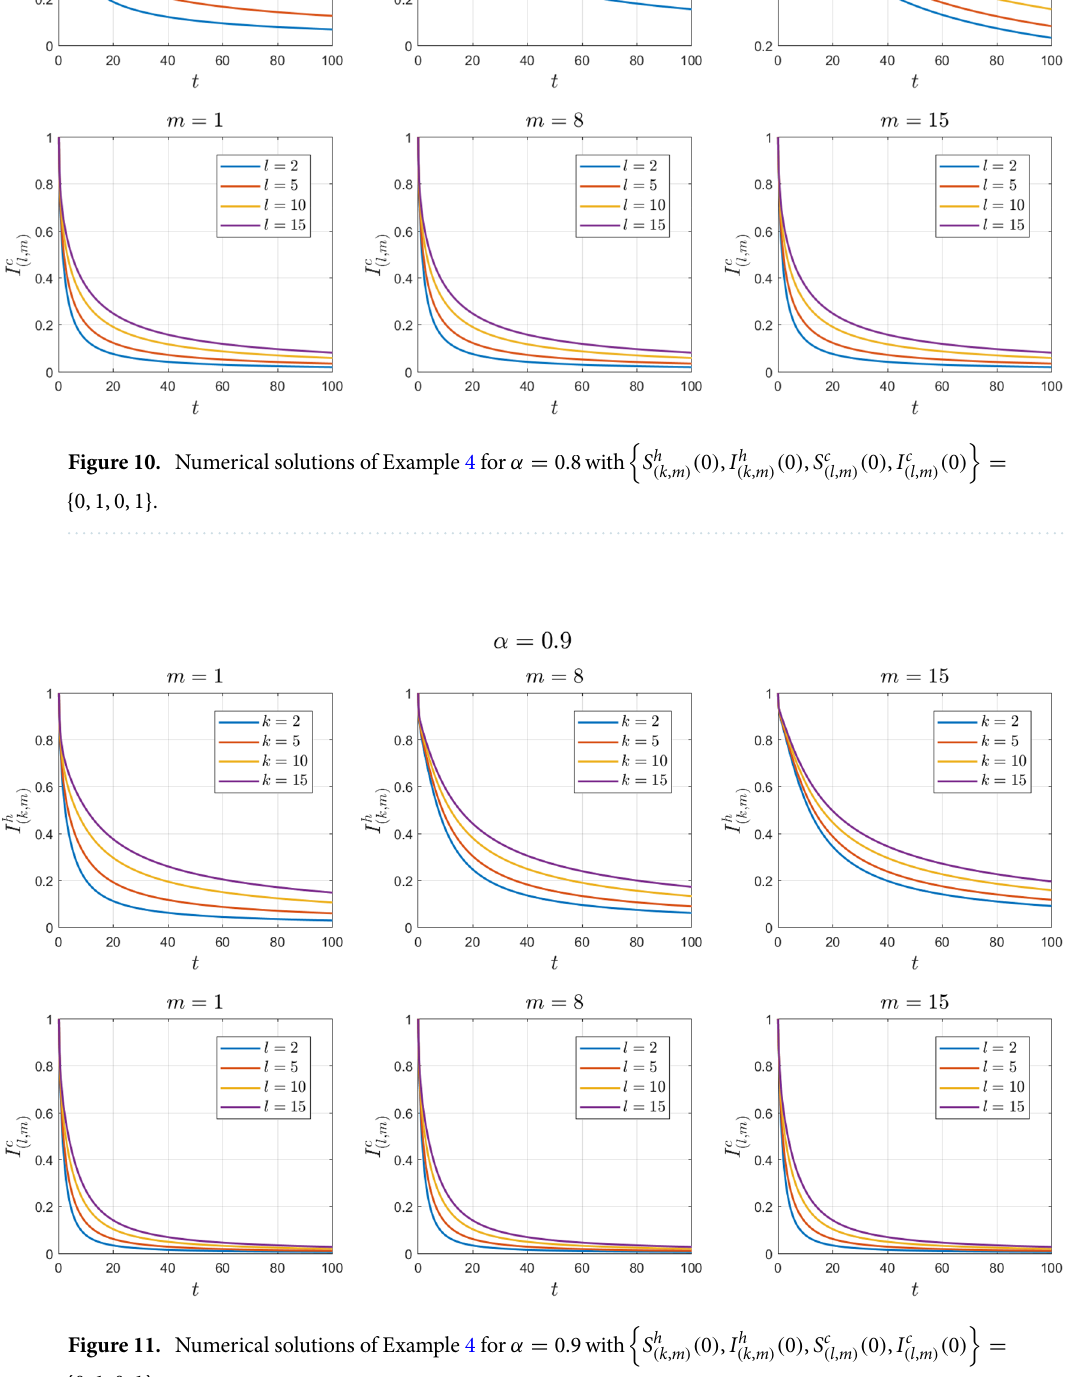
Figure 11. Numerical solutions of Example 4 for α = 0.9 with { 0, 1, 0, 1 }